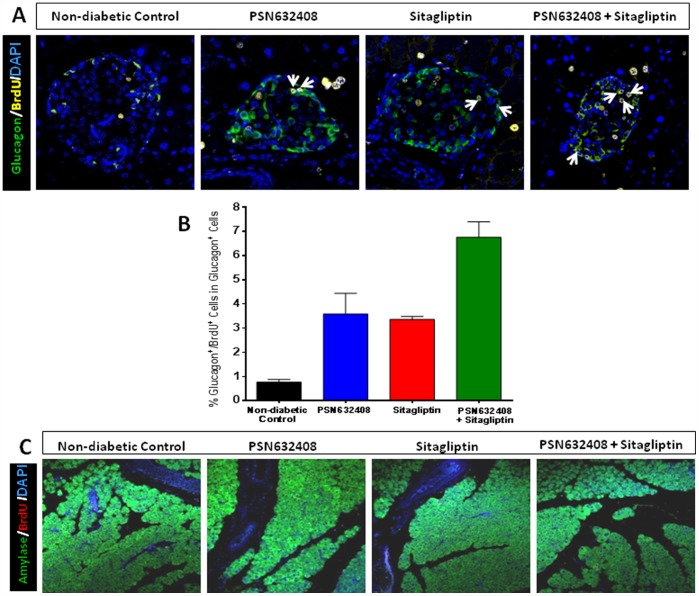
(A) Immunostaining of glucagon (green), BrdU (yellow), and DAPI (blue) in pancreas sections from BrdU-terated non-diabetic control mice and diabetic mice with restored normoglycemia after 7 weeks treatment with PSN632408, sitagliptin, or PSN632408 combined with sitagliptin.White arrows indicate glucagon/BrdU/DAPI co-positive cells. (B) The percentage of glucagon/BrdU/DAPI co-positive cells among total glucagon positive cells was significantly increased in mice treated with PSN632408 and sitagliptin combination compared with mice treated with PSN632408 alone or sitagliptin alone (p<0.05, n = 3 to 5 mice per group). (C) Immunostaining of amylase (green), BrdU (red), and DAPI (blue) in pancreas sections from BrdU-treated non-diabetic control mice and diabetic mice with restored normoglycemia after 7 weeks treatment with PSN632408, sitagliptin, or PSN632408 combined with sitagliptin.